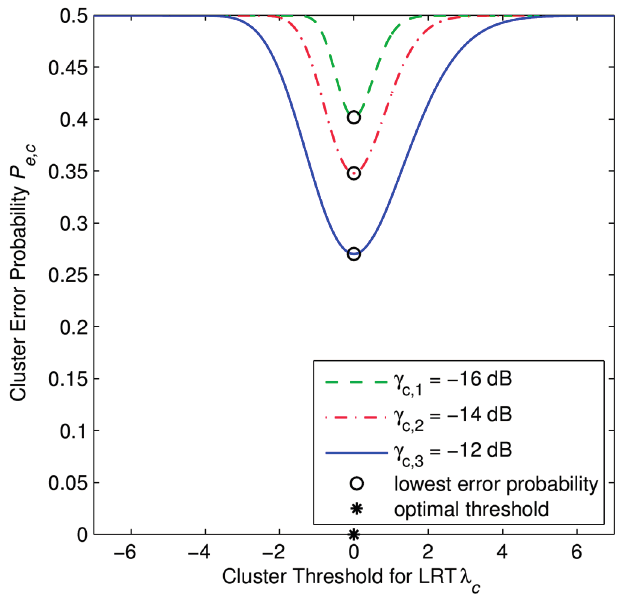
Figure 3. Derivation of the optimal cluster threshold in the SHC scheme. The error probability at a cluster head P e,c as a function of cluster threshold λ c with P 1 = P 0 = 0.5, M = 50 samples, N = 4 SUs.